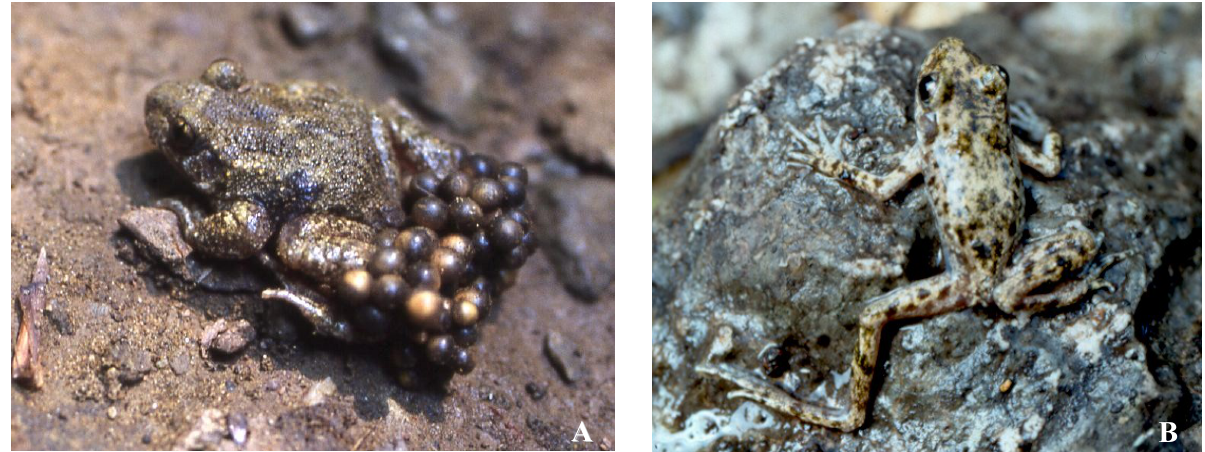
Figure 1. Continental and insular alytines. ( A ) The European midwife toad, Alytes (A.) obstetricans . This is a male carrying its developing offspring (Salt del Sallent, Catalan Pyrenees). ( B ) The ferreret, Alytes (Baleaphryne) muletensis , is the only extant insular alytine, now confined to a few inaccessible mountain canyons in the island of Mallorca. Notice its long limbs, the papilla-like endings of the digits and the smooth skin. (Alcanella, Serra de Tramuntana,